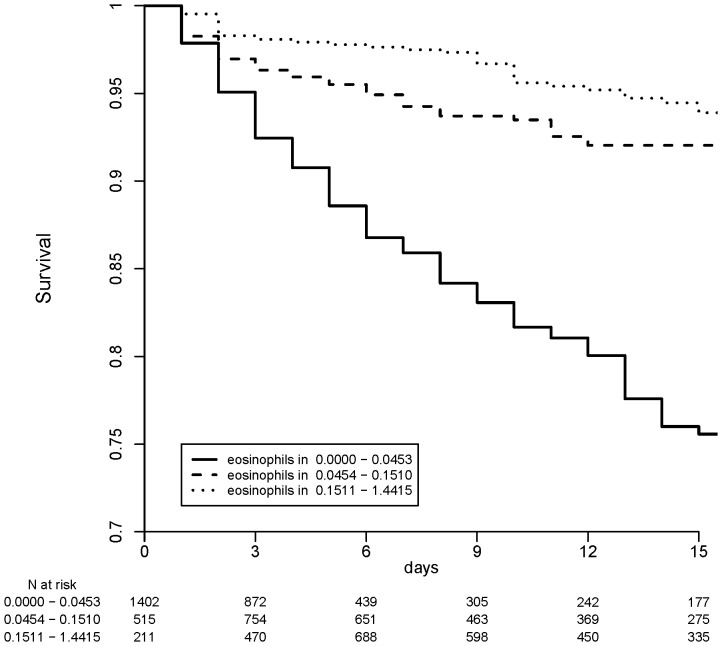
Survival curves according to eosinophil count.Legend: The continuous curve represents mortality in patients with an eosinophil count lower than 0.0454·103/uL. The dashed line represents survival in patients with an eosinophil count from 0.0454–0.15·103/uL. The dotted curve represents survival in patients with an eosinophil count higher than 0.15·103/uL.